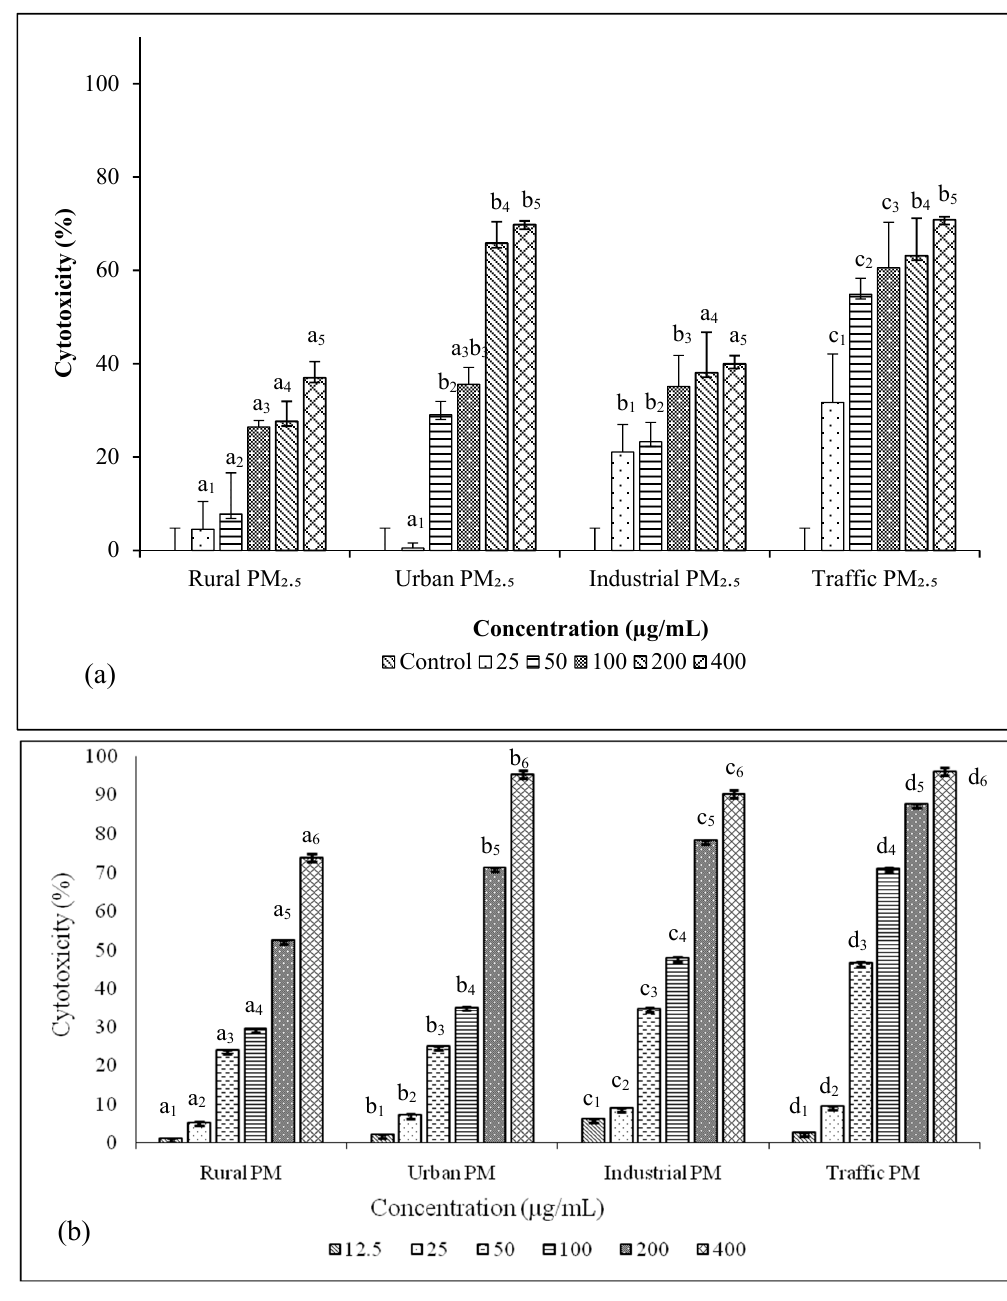
Figure 3. of PM 2.5 samples measured in A549 cells by MTT assay ( a ) and lactate dehydrogenase release Figure 3. Cytotoxicity of PM 2.5 samples measured in A549 cells by MTT assay ( a ) and lactate assay (LDH) release assay ( b ), N = 6 ± SD. Dataset not sharing common superscript vary significantly dehydrogenase release assay (LDH) release assay ( b ), N = 6 ± SD. Dataset not sharing common p < 0.05 (DMRT). superscript vary significantly p < 0.05